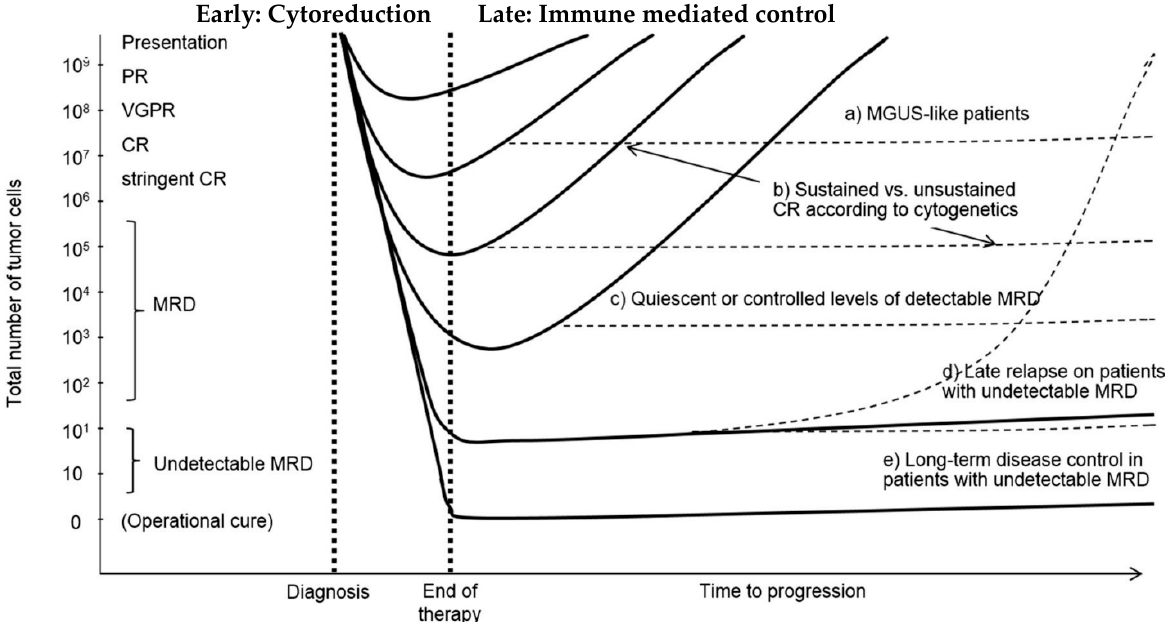
Figure 6. A hypothetical model proposing two phases of anti-myeloma therapy consisting of initial de-bulking followed by modulation of the bone marrow microenvironment and reprogramming of the host’s immune system resulting in a sustained disease control (modified from [24]). In situations where the initial de-bulking by chemotherapy is not followed by modulation of the bone marrow microenvironment and enhancement of the hosts’ immune system a rapid regrowth of tumor may occur. The figure was originally intended to illustrate the importance of obtaining and maintaining deep and sustained responses with MRD negativity.